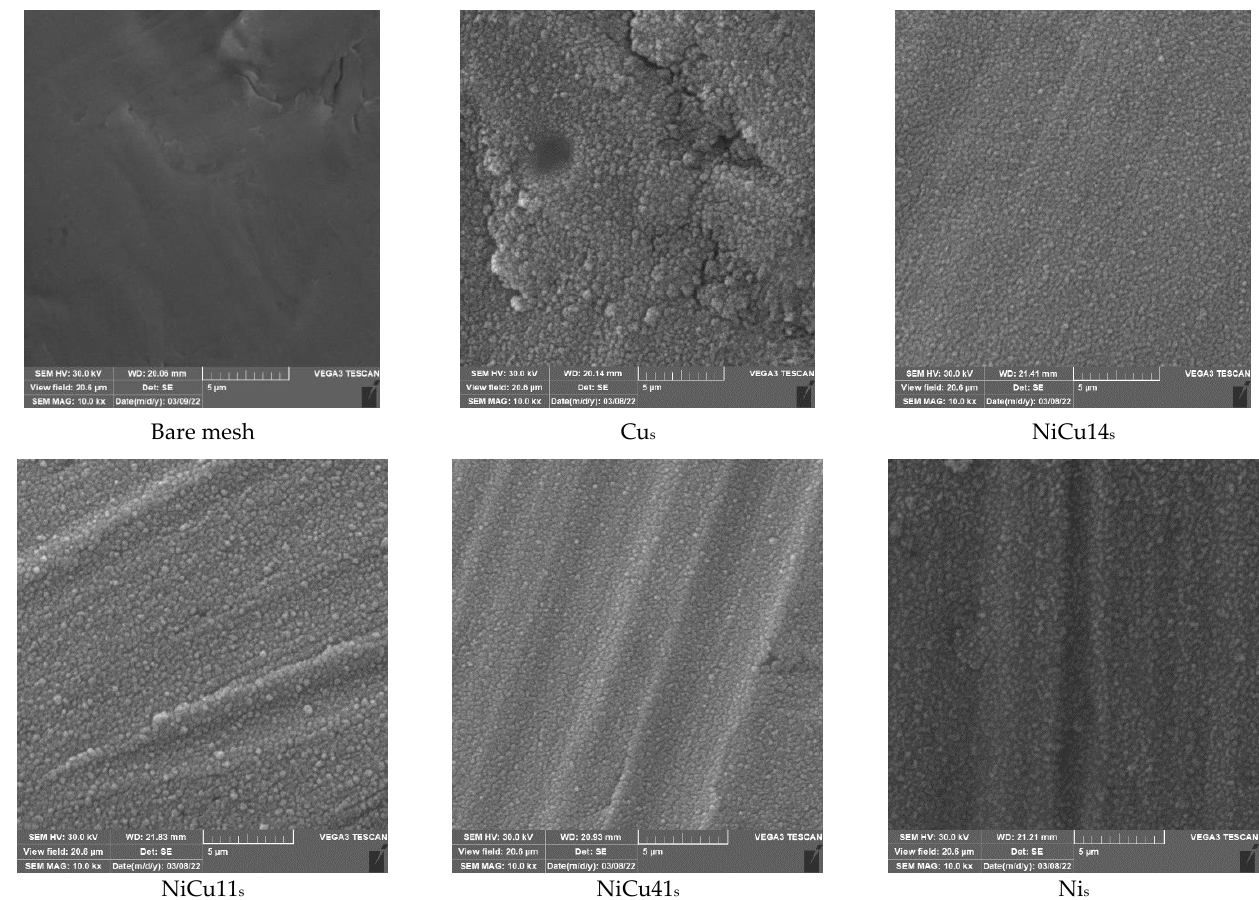
Figure 1. SEM images of the Ni-Cu oxide layers with various Ni:Cu molar ratios deposited on stainless steel meshes by plasma jet sputtering.